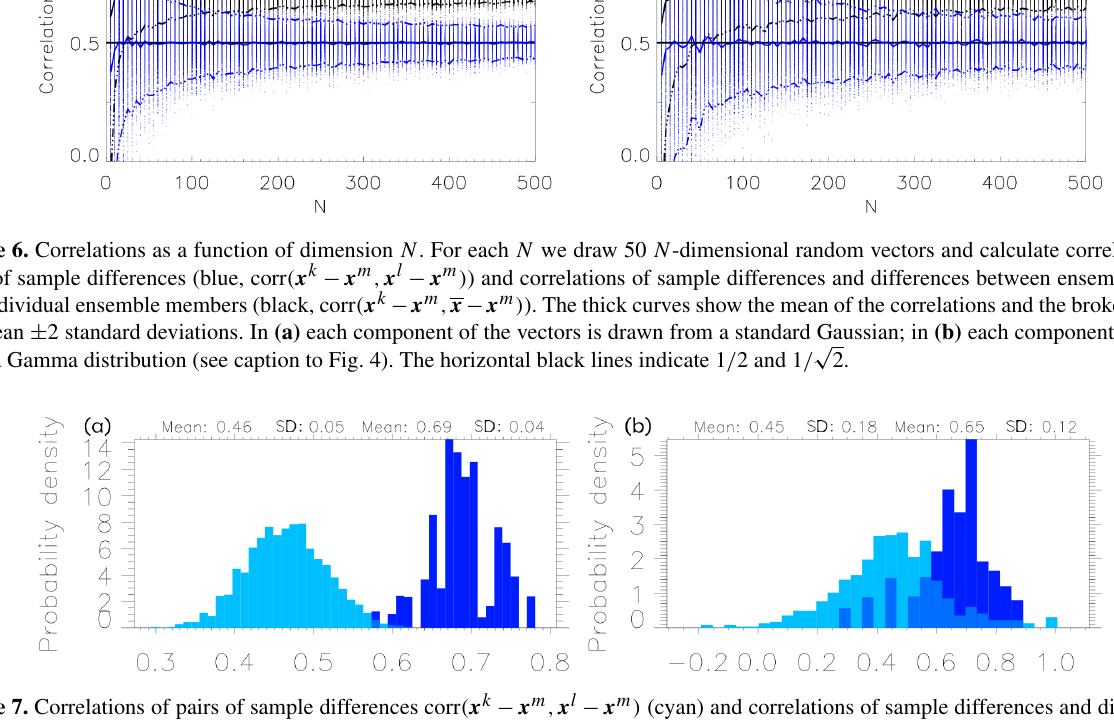
Figure 7. Correlations of pairs of sample differences corr ( x k − x m , x l − x m ) (cyan) and correlations of sample differences and differences between sample mean and individual sample members corr ( x k − x m , x − x m ) (blue). (a) Daily mean precipitation June from AgERA. (b) Monthly climatology of near-surface temperature in